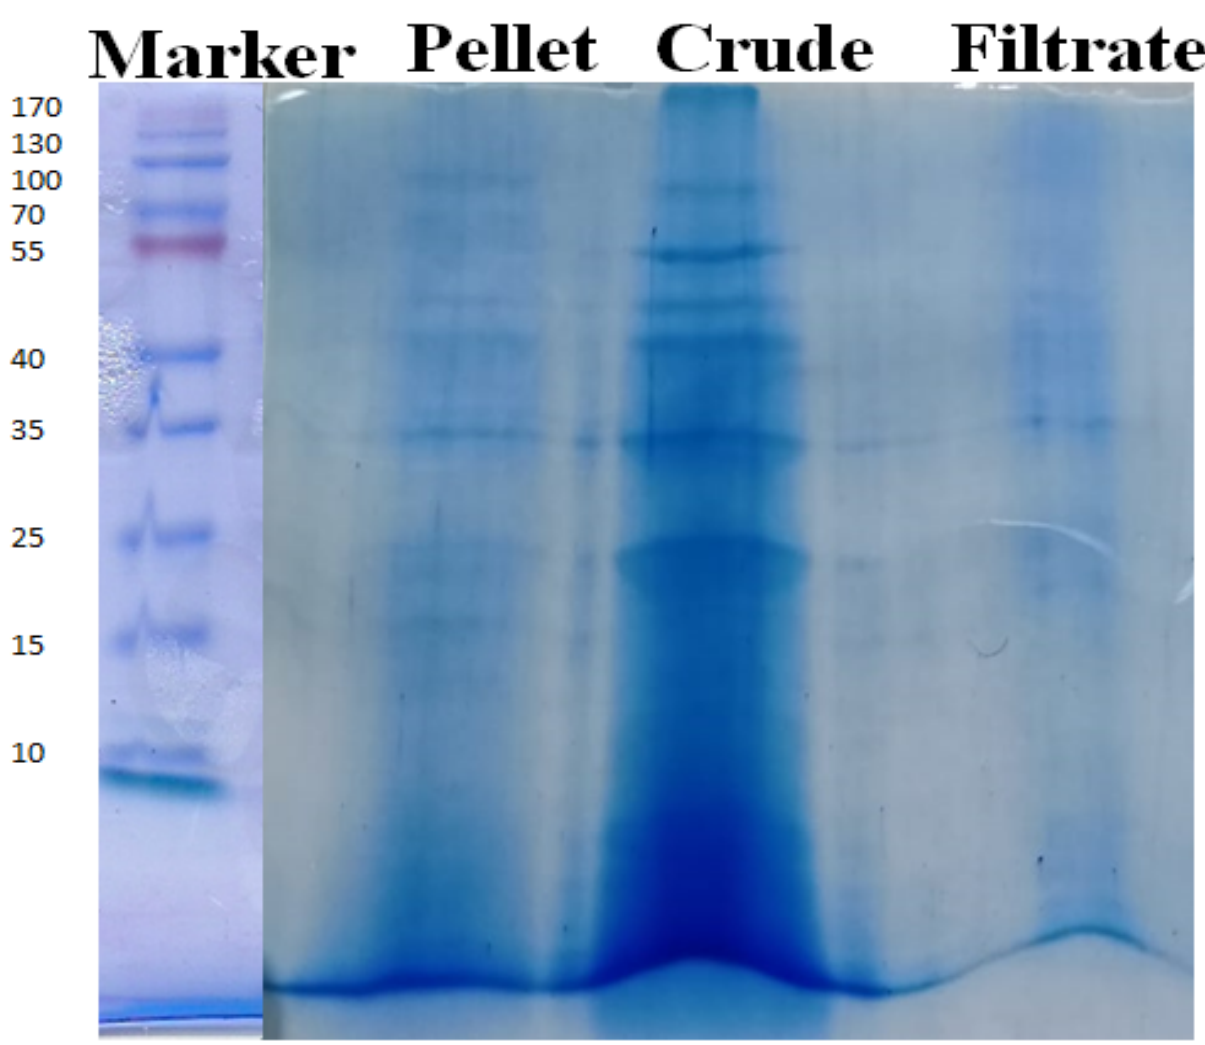
Figure 2. SDS-PAGE of the purified protease, crude, and precipitates.